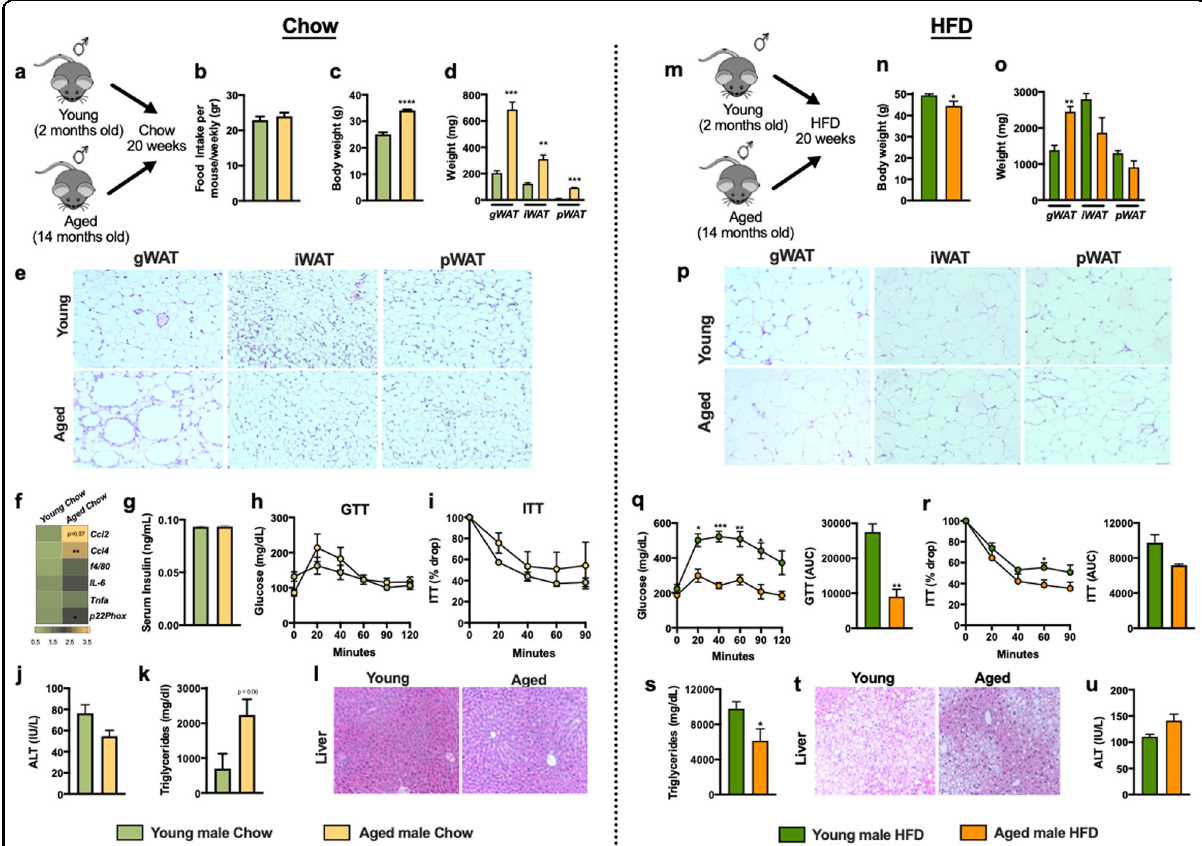
Fig. 1 Aging mitigates metabolic disease severity in male mice. 2-month-old (Young) and 14-month-old (Aged) male C57BL/6 mice, ( n = 4 – 5/ condition) were housed at 22 °C (T S ) and fed a Chow or a HFD for up to 20 weeks. a Schematic representation of aged model used. b Weekly food intake. c Body weight at time of harvest. d White adipose tissue (WAT) weight: gonadal WAT (gWAT), inguinal WAT (iWAT) and perirenal WAT (pWAT). e gWAT, iWAT and pWAT hematoxylin eosin (H&E) staining. f Heatmap of gWAT mRNA levels of Ccl2, Ccl4 , f4/80 , Il6, Tnf and p22phox ( n = 3) fold change relative to chow fed young male. g Fasting serum insulin levels. h Glucose tolerance test (GTT). i Insulin tolerance test (ITT). j Liver triglycerides. k Liver H&E staining. l Serum Alanine transaminase (ALT) levels. m Schematic representation of DIO model used. n Body weight at time of harvest. o White adipose tissue (WAT) weight: gonadal WAT (gWAT), inguinal WAT (iWAT) and perirenal WAT (pWAT). p gWAT, iWAT and pWAT hematoxylin eosin (H&E) staining. q Left, glucose tolerance test (GTT) and Right, GTT area under the curve (AUC). r Left, insulin tolerance test (ITT) and Right, ITT area under the curve (AUC). s Liver triglycerides. t Liver H&E staining. u Serum Alanine transaminase (ALT) levels. A representative of 2 individual experiments. Data represent means + SE. b , c , e – h , j , n , o , q – s , u ) Unpaired Student t test * P < 0.05, ** P < 0.005, *** P < 0.0005 and **** P <